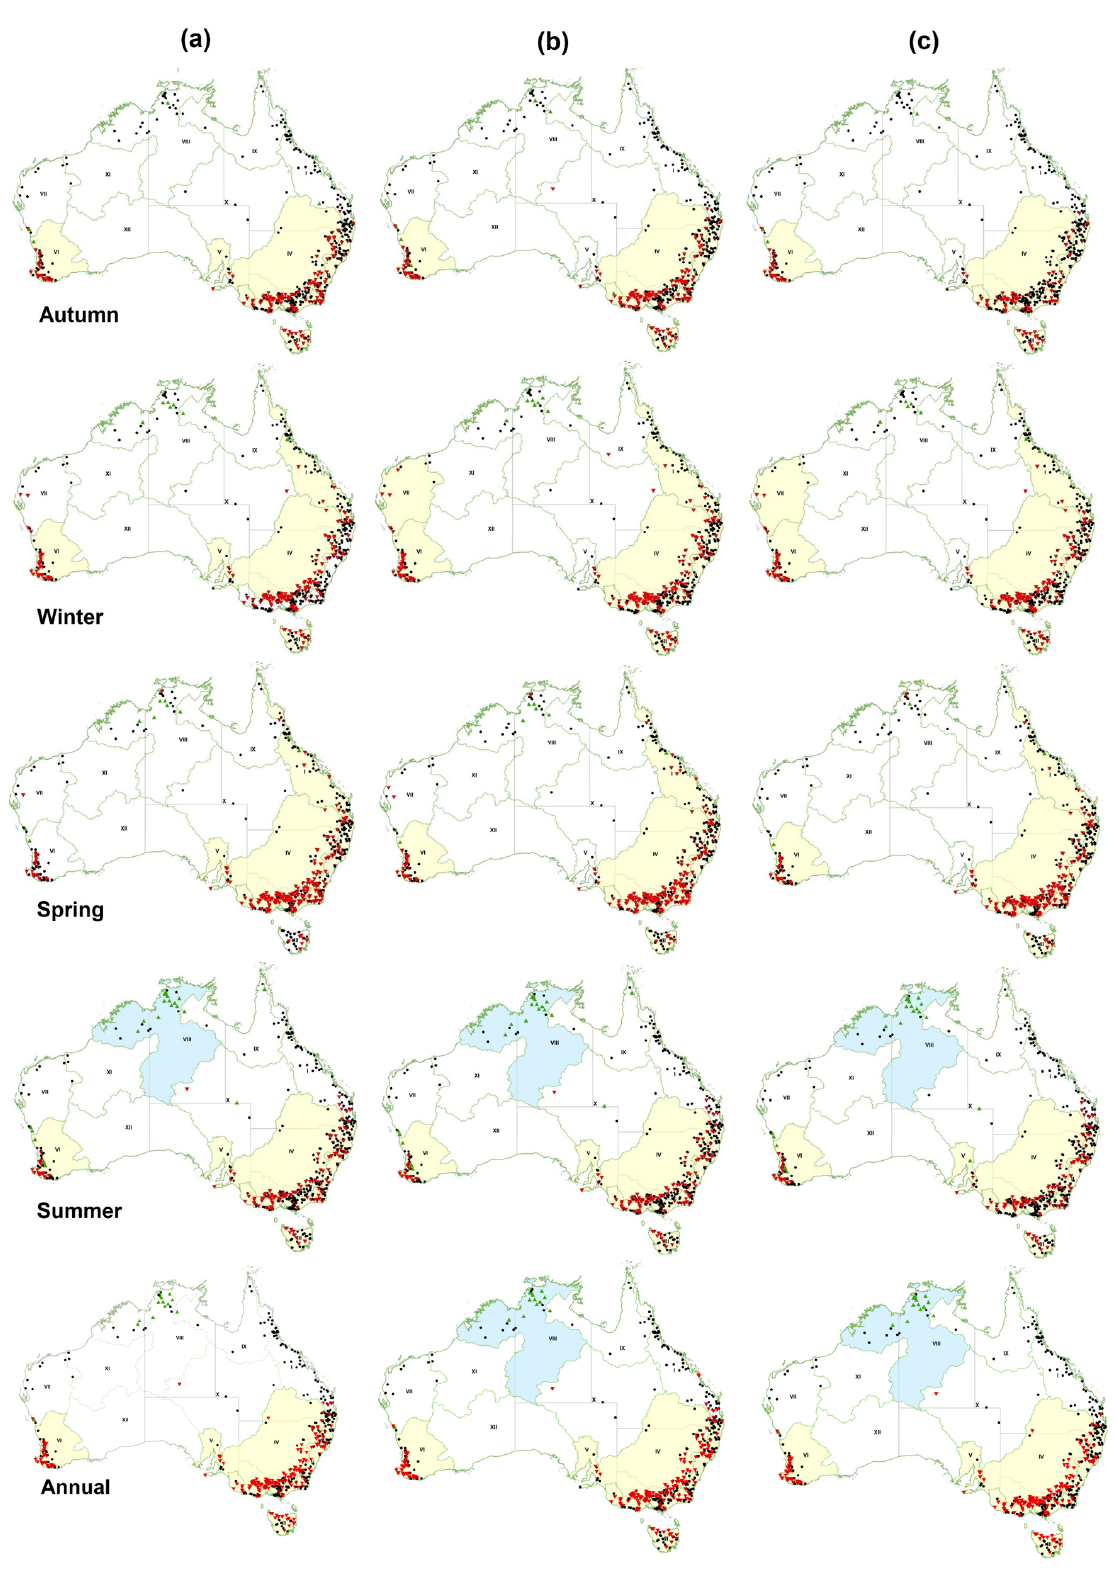
Figure 7. Maps showing seasonal trends using the (a) MK3, (b) MK3bs and (c) MK4 tests. Results are reported for autumn, winter, spring, summer and annually (water year) ( p < 0 . 1). Upward-pointing triangles (green) indicate significant increasing trends, and downward- pointing triangles (red) indicate significant decreasing trends. Grey dots indicate stations with no trends. Drainage divisions with positive and negative trends with regional significance at p < 0 . 10 are coloured blue and yellow